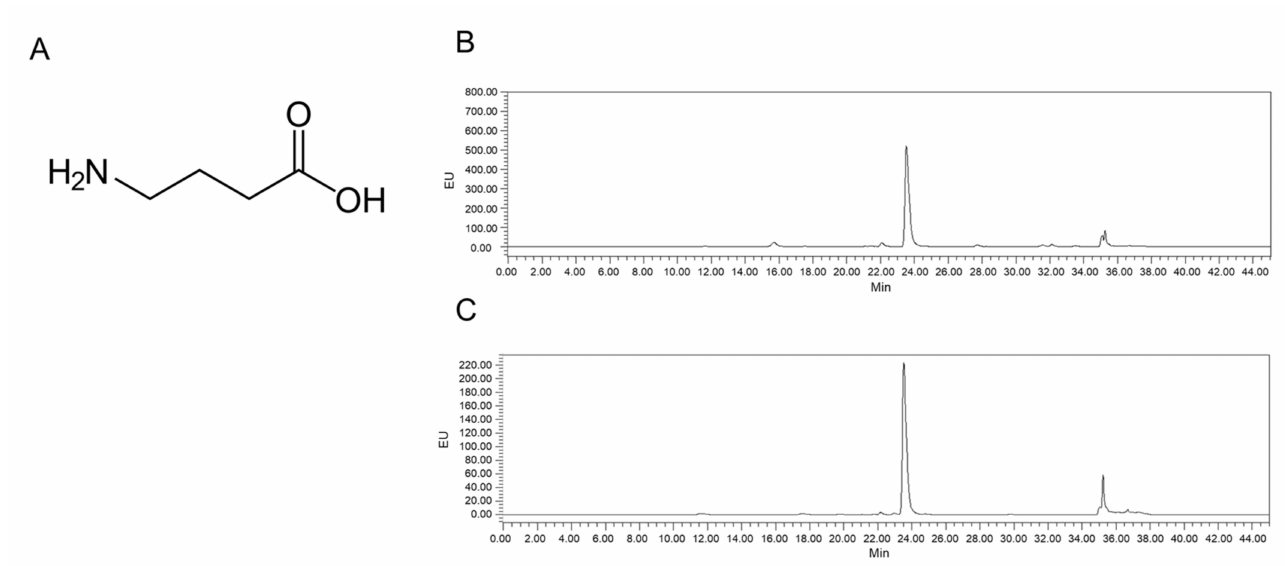
Figure 1. ( A ) Chemical structure and ( B ) high-performance liquid chromatography (HPLC) chromatograms of Lactobacillus - fermented γ -aminobutyric acid (LB-GABA), and ( C ) GABA